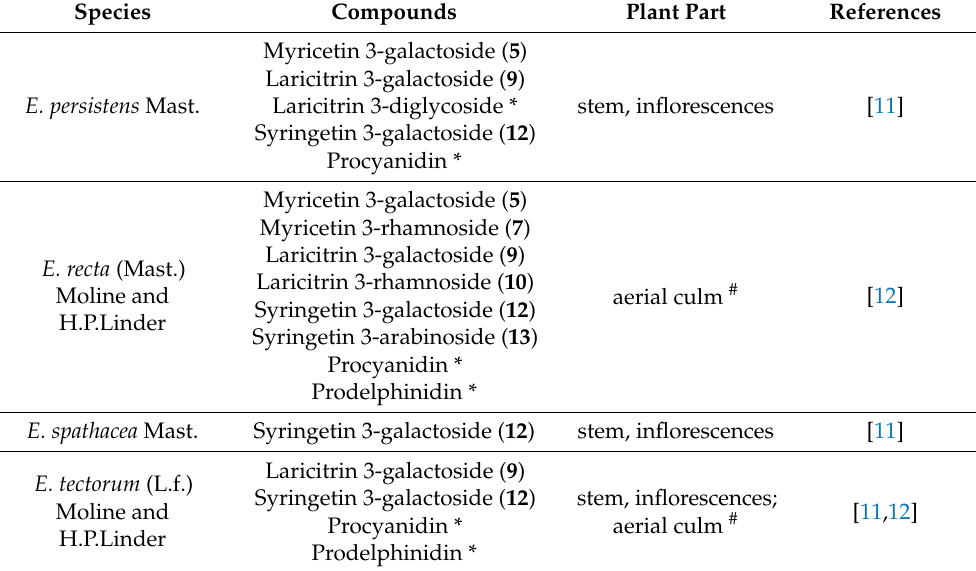
Table 3. Cont . Species